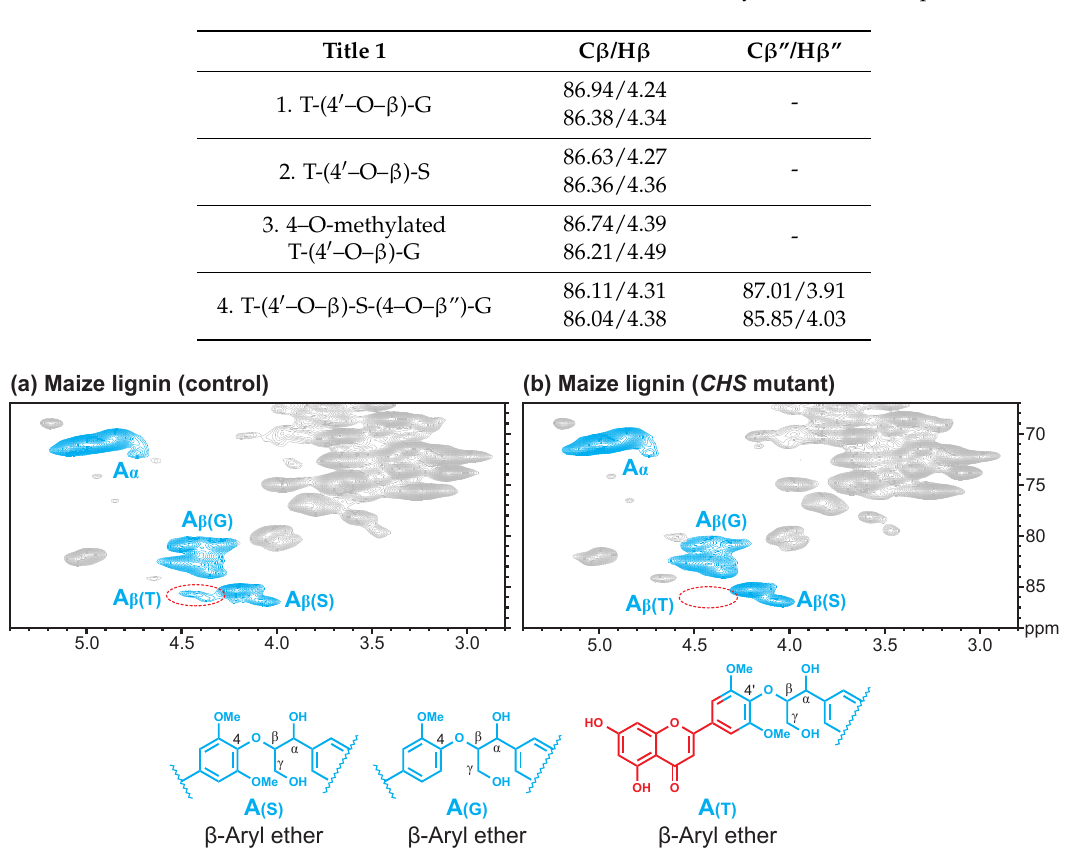
Figure 1. 1H–13C heteronuclear correlation (HSQC) spectra of acetylated ( a ) and non-acetylated ( b ) milled wood lignin of wheat straw overlaid with the nuclear magnetic resonance (NMR) data from four tricin-containing model compounds. Table 1. Chemical shift of the C β /H β and C β ”/H β ” of the non-acetylated model compounds.